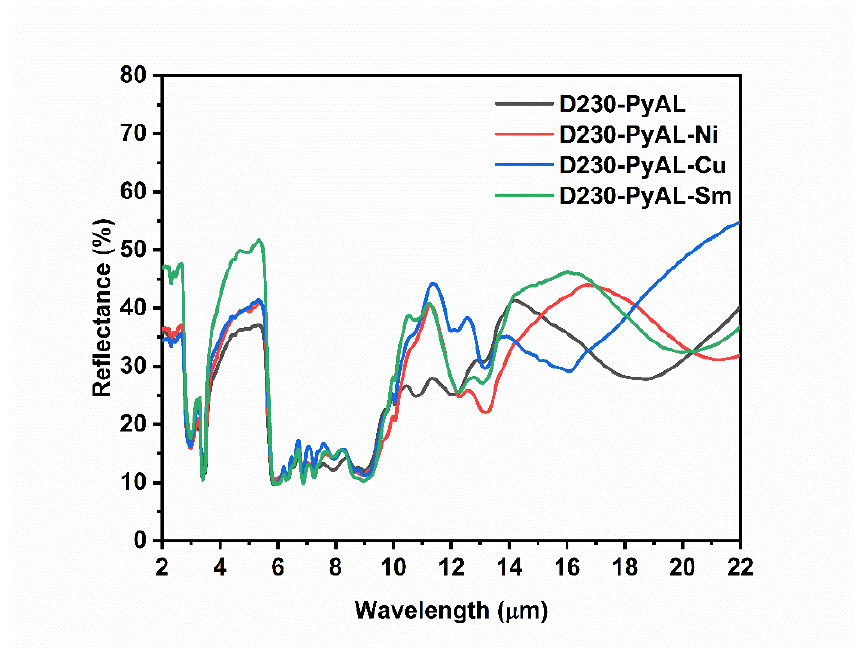
Figure 5. Reflectance curves of polymers and coordination polymer coatings.